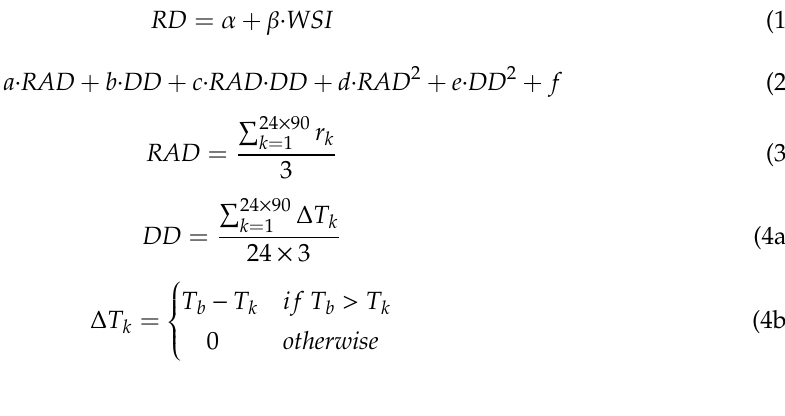
Table 1. Coe ffi cients required to obtain the reference specific demand in winter [41].